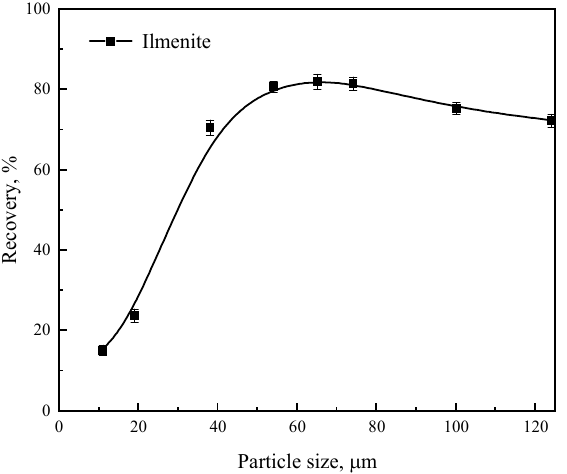
Figure 1. Effect of particle size on flotation recovery of ilmentie treated with sodium oleate (pH:6.0, 2.0 × 10 −4 mol·L –1 sodium oleate).